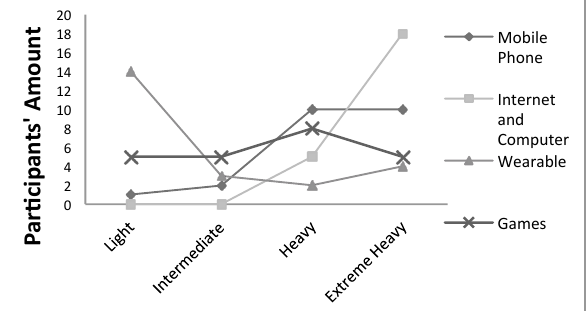
Figure 5. Participants' Familiarity with Technologies